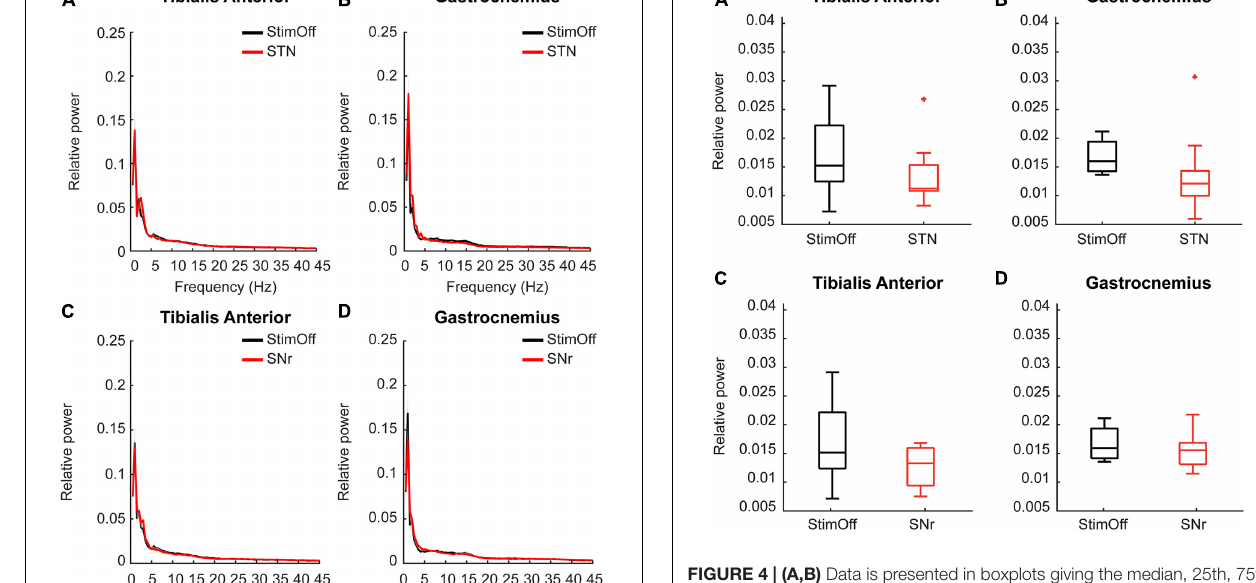
FIGURE 4 | (A,B) Data is presented in boxplots giving the median, 25th, 75th percentile, min and max. Alpha/low beta power observed in ‘StimOff’ can be significantly lowered by ‘STN’ in both the TA (upper left panel, p = 0.015) and GA (upper right panel, p = 0.015). (C,D) Data is presented in boxplots giving the median, 25th, 75th percentile, min and max. There was no significant difference of the alpha/low beta power observed in ‘StimOff’ vs. ‘SNr’ in both the TA (lower left panel) and GA (lower right panel). + Indicates statistically significat differences.